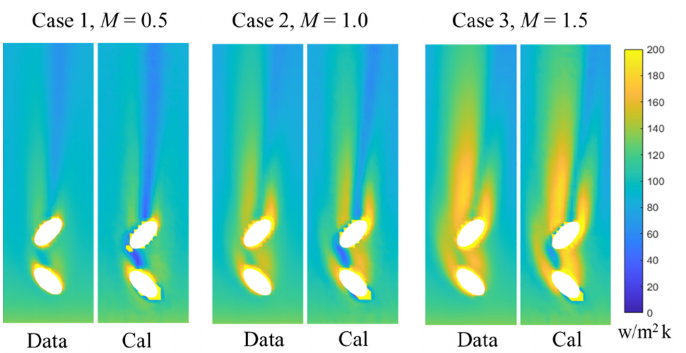
Figure 4. Comparison of heat transfer coefficient contours between the data and calculation at different M .